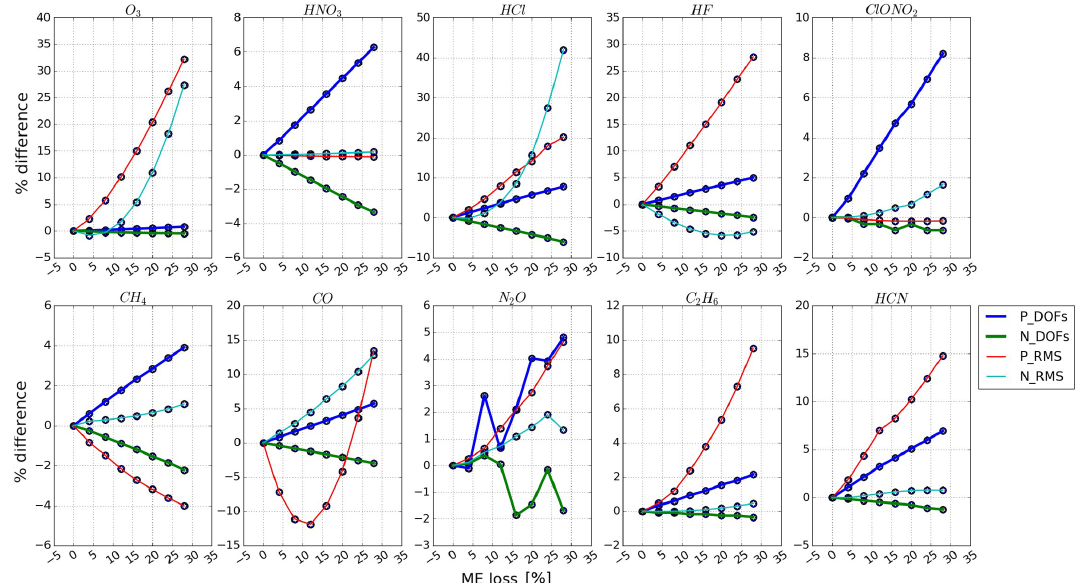
Figure 15. The same as Fig. 14 but for DOFs and rms of the fitting residual. The acronyms in the legend are similar to those in Fig. 14.